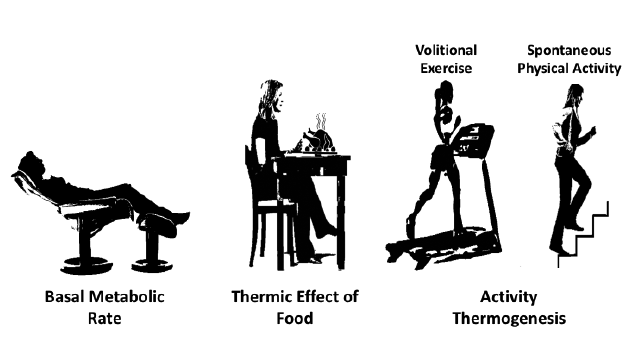
Figure 1. Main components of energy expenditure in humans: basal metabolic rate, thermic effect of food, and activity thermogenesis. Activity thermogenesis is subdivided into volitional exercise and spontaneous physical activity. For those individuals not engaged in any form of volitional exercise, SPA is the sole responsible for activity